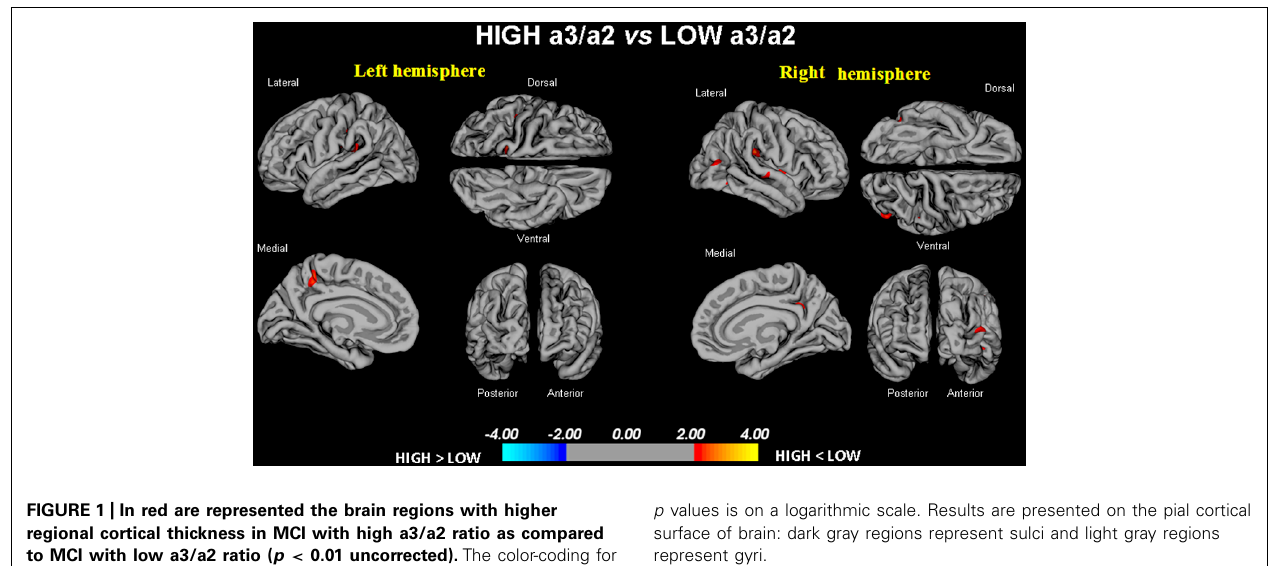
p values is on a logarithmic scale. Results are presented on the pial cortical surface of brain: dark gray regions represent sulci and light gray regions represent gyri.